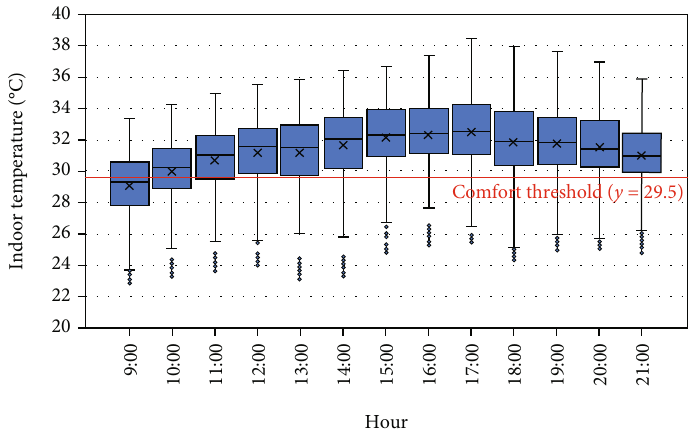
Figure 15: Indoor temperatures at hourly intervals.